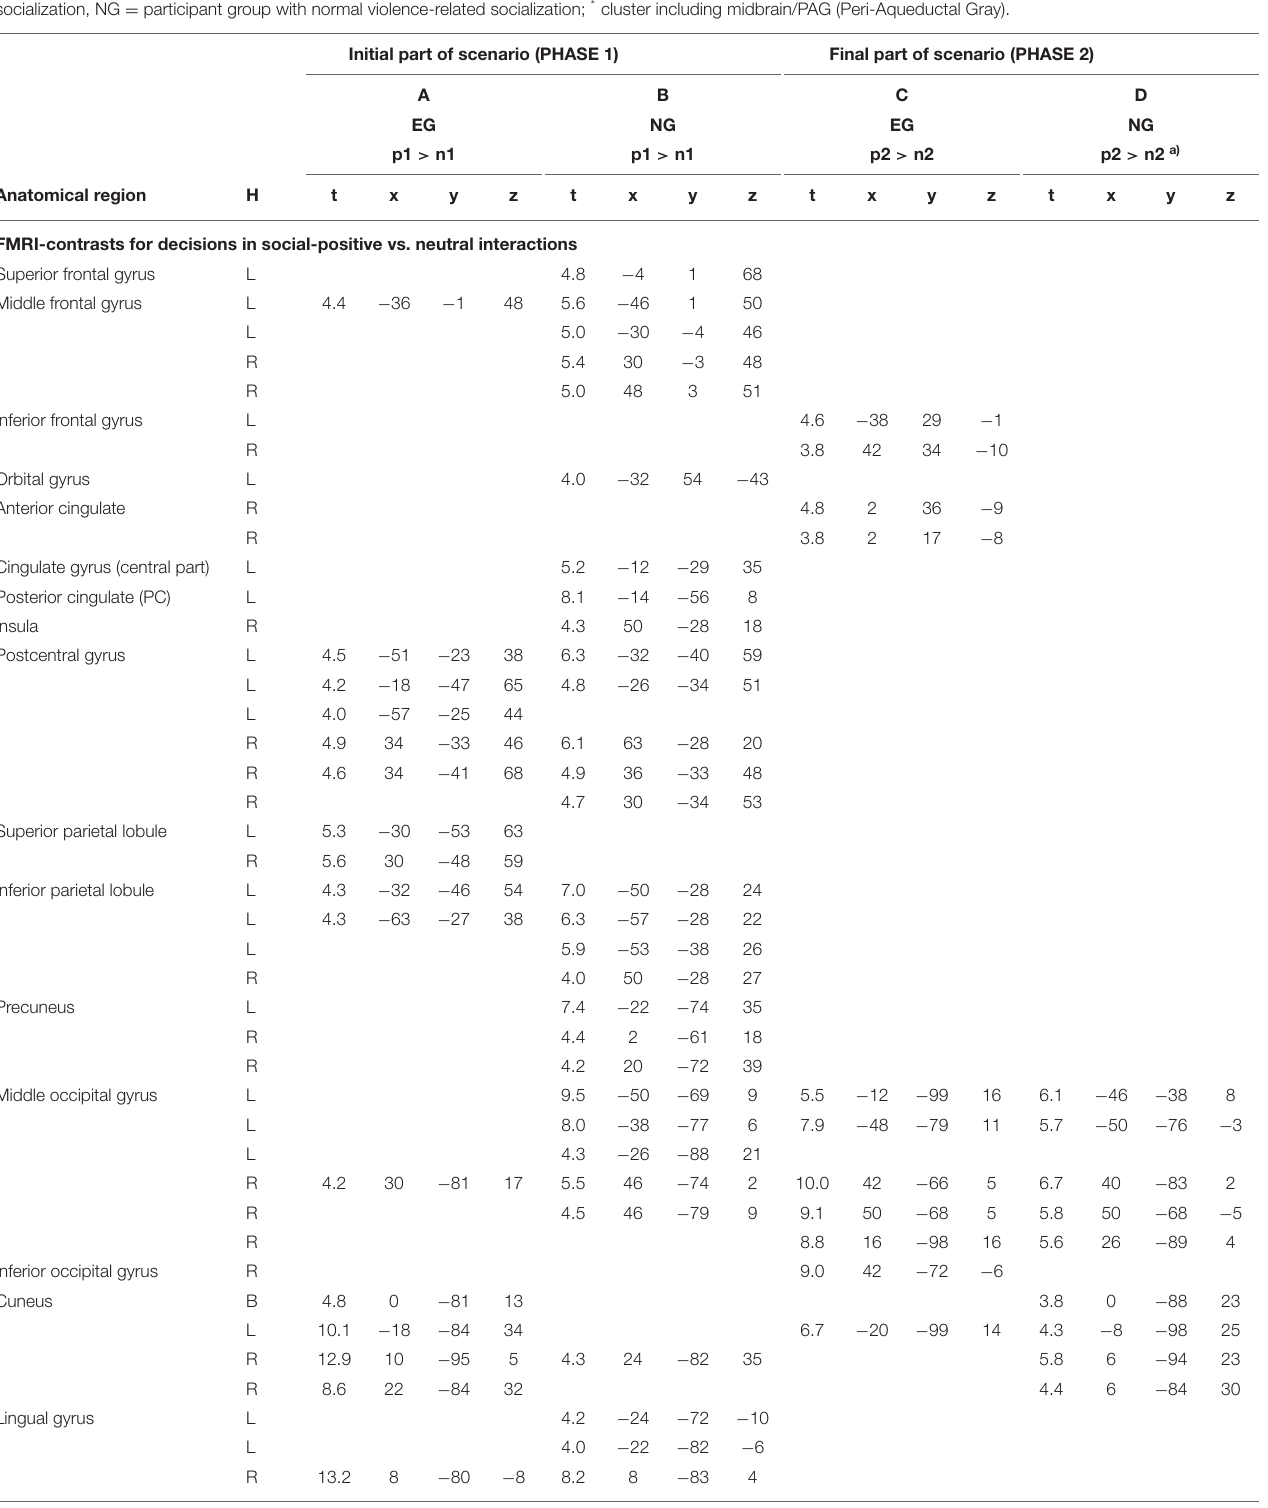
TABLE 3 | Anatomical regions, peak activation t-values, and Talairach-coordinates for contrasts (arranged in columns A–D) including the emotional stimulus category social positive (p) and neutral (n) separately for the initial (p1 and n1) and the final part of the scenario (p2 and n2); H, hemisphere; L, left; R, right; B, bi-hemispheric;